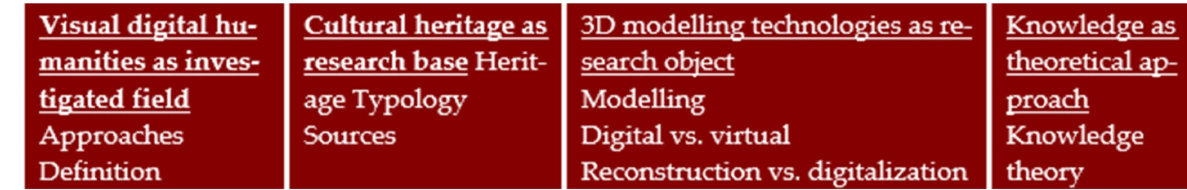
Figure 2. Definitions section